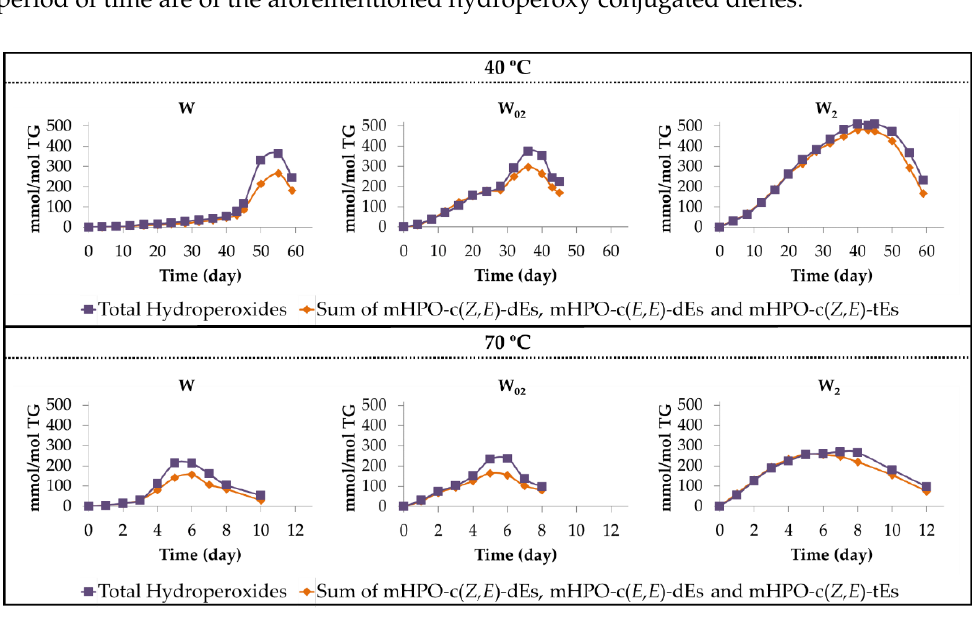
Figure 5. Evolution of the concentration of both primary oxidation compounds and total hydroperoxy groups, in the different walnut oil samples throughout the storage, at either 40 °C or 70 °C, up to advanced stages of the oxidation process.